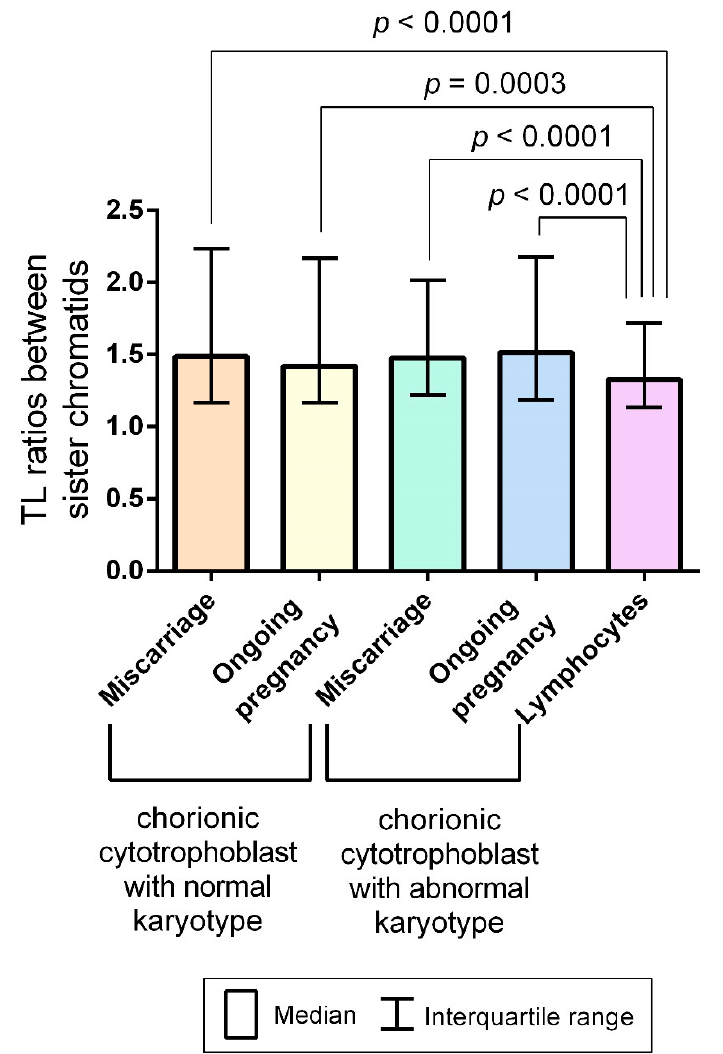
Figure 6. Column bar charts of telomere length (TL) ratios between the sister chromatids of chro- mosomes 16 in the chorionic cytotrophoblast from miscarriages and ongoing pregnancies and in PHA-stimulated peripheral blood lymphocytes of healthy adults. TL ratios do not differ among karyotypically normal and abnormal chorionic cytotrophoblast samples from miscarriages and ongo- ing pregnancies (the Kruskal–Wallis test, p = 0.22). Still, they are significantly higher than those in PHA-stimulated lymphocytes (the Mann–Whitney U test, p < 0.0001, p = 0.0003).